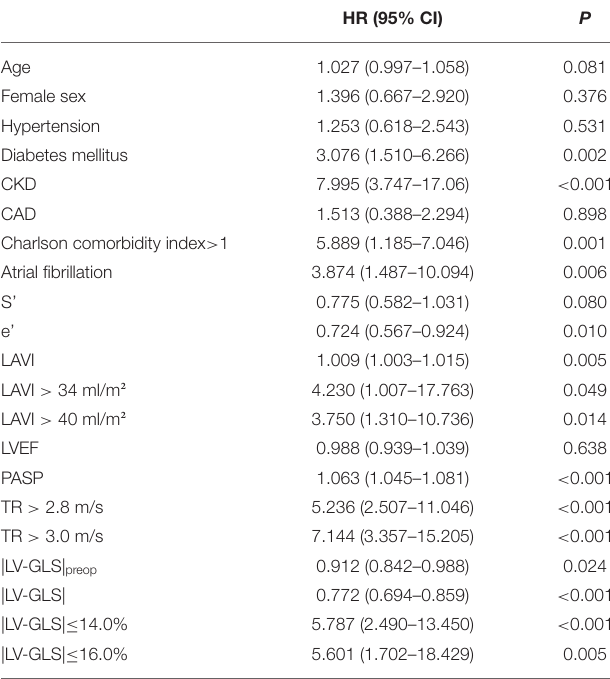
TABLE 3 | Cox proportional hazard regression univariate analysis of clinical outcomes.